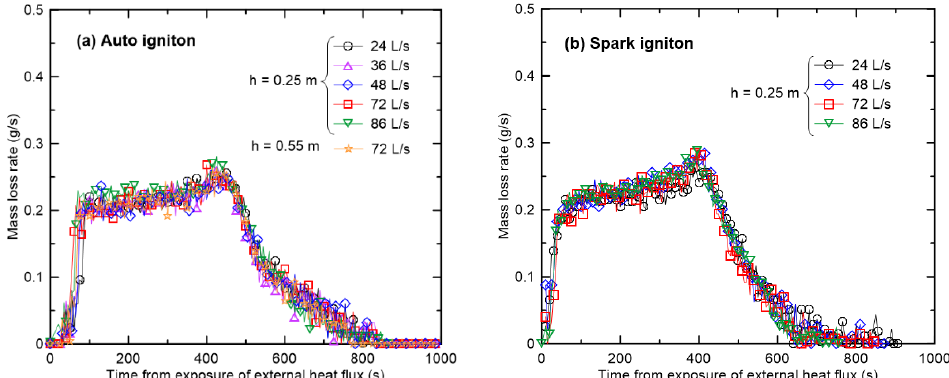
Figure 10. Time histories of mass loss rate with the changes in exhaust flow rate and hood height (h) for auto and spark ignitions.